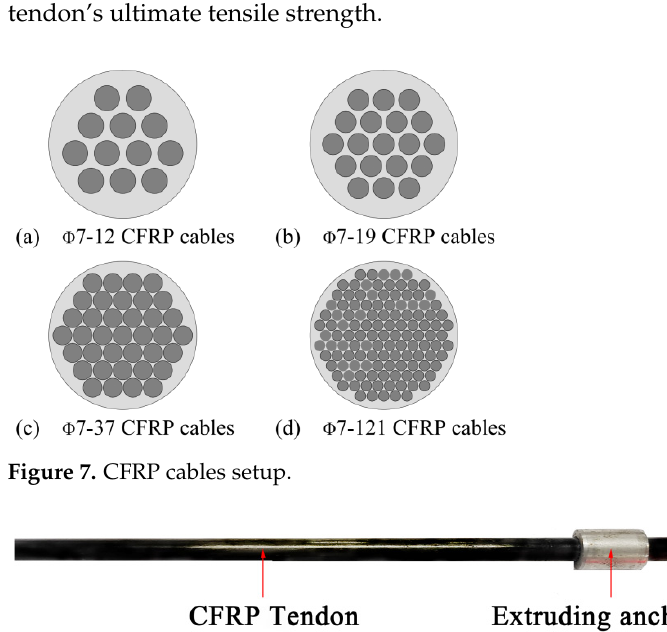
Figure 9. Static load tests result.